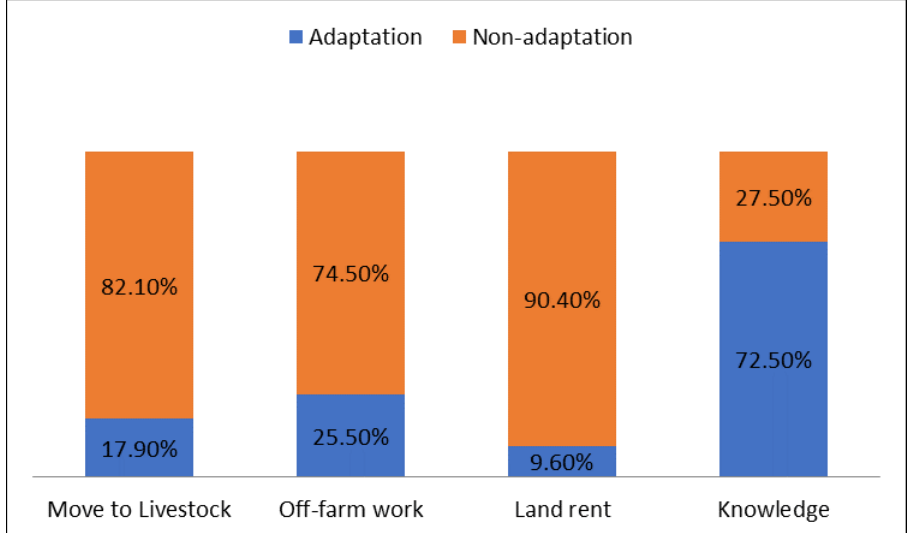
Figure 2. On-farm adaptation practices.